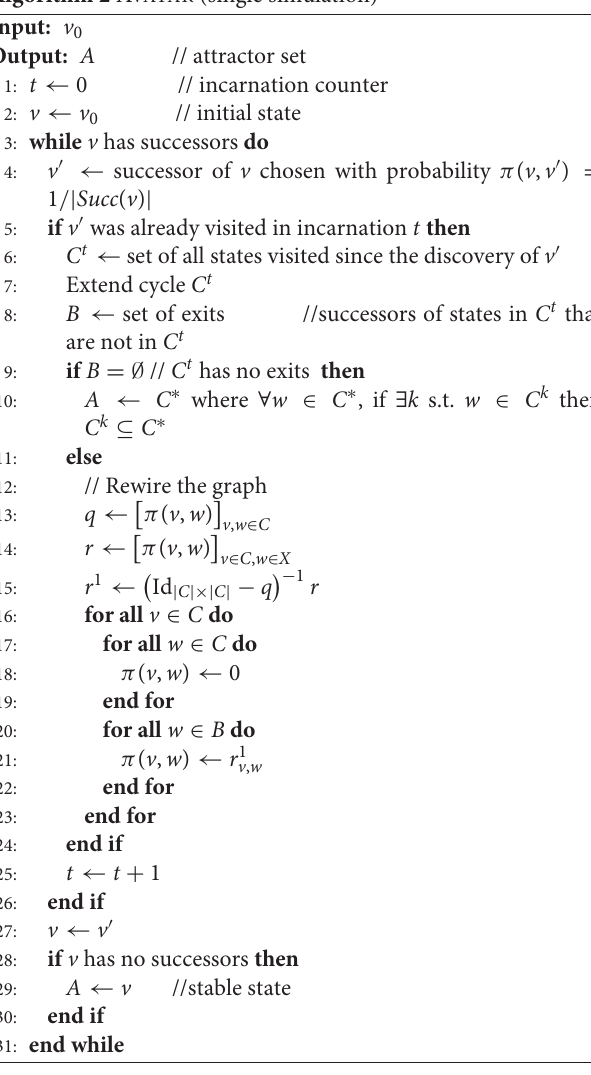
Algorithm 2 A VATAR (single